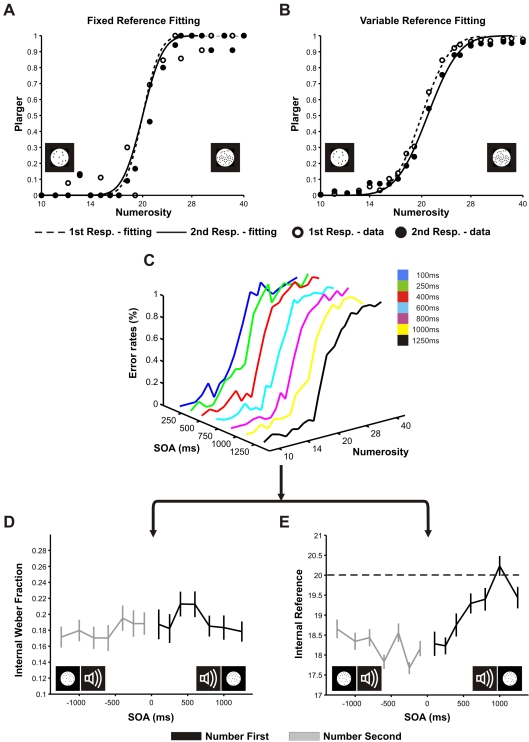
Interactions between interference (SOA) and decisional (log numerical distance) variables.A) Probability of a response “larger” as a function of the numerosity when the number task was responded first (open circles) and second (solid circles). Both curves can be fit by a sigmoidal function (dashed and solid lines respectively). The width of this function, which is an estimate of the internal Weber Fraction (w), is unaffected by task order. B) Same data as in A, fit to a sigmoid function with a varying reference. The internal reference (50% response) is closer to the objective reference (20) when the number task is responded first. C) Dependence of error rates as function of numerosity for different SOA values, represented in different colours. For number task responded second trials. Error rates and their distribution are unaffected by SOA. (SOA color labels: blue = 100 ms, green = 250 ms, red = 400 ms, cyan = 600 ms, magenta = 800 ms, yellow = 1000 ms and black = 1250 ms) D, E) The internal weber fraction is not affected by SOA (D), while the internal reference increase for larger SOAs when number task was presented second (E). Both parameters estimated with the same fit (equation 2). Black lines correspond to Number responded second trials and grey lines corresponds to Number responded first trials.